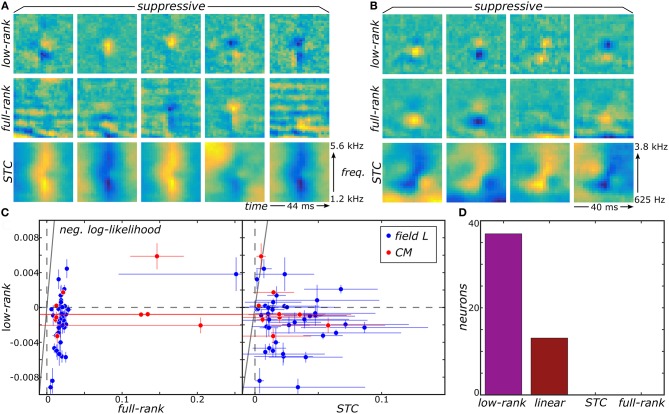
Low-rank MNE, full-rank MNE, and STC models were optimized on a dataset of 50 avian auditory forebrain neurons. Logical OR and logical AND FB models were fit using linear combinations of the subspace components of each method. Logical AND FB models from two example neurons are shown (A,B). The quality of each model is measured using the difference between the mean negative log-likelihood of the model and the linear MNE model evaluated on the test sets and plots summarize predictive ability across the population of neurons (C). A bar plot quantifies the number of neurons in the population best fit by each model (D). Note low-rank and linear MNE models outperform all STC and full-rank MNE models across the population.